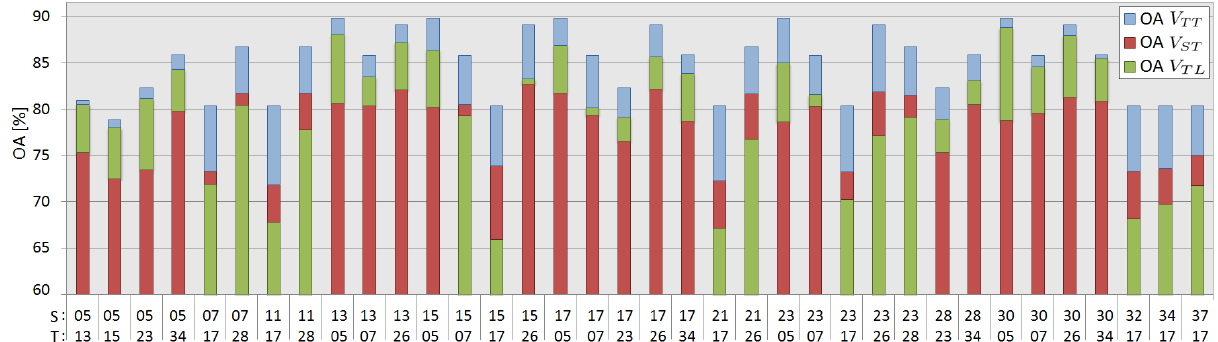
Figure 2: Overall accuracy [%] for the 36 test pairs, obtained for three classification variants (red: V ST ; blue: V TT ; green: V TL ). S : number of the patch corresponding to the source domain; T : number of the patch corresponding to the target domain. tion 4.1. The OA achieved for all three variants is presented in figure 2. The red bars indicate the OA for variant V ST , i.e. the application of a classifier trained on source domain data to the tar- get domain without adaptation, whereas the blue bars correspond to the OA for variant V TT , i.e. the case when the classifier was trained using target domain data. The green bars correspond to variant V TL , i.e. to the results of DA.